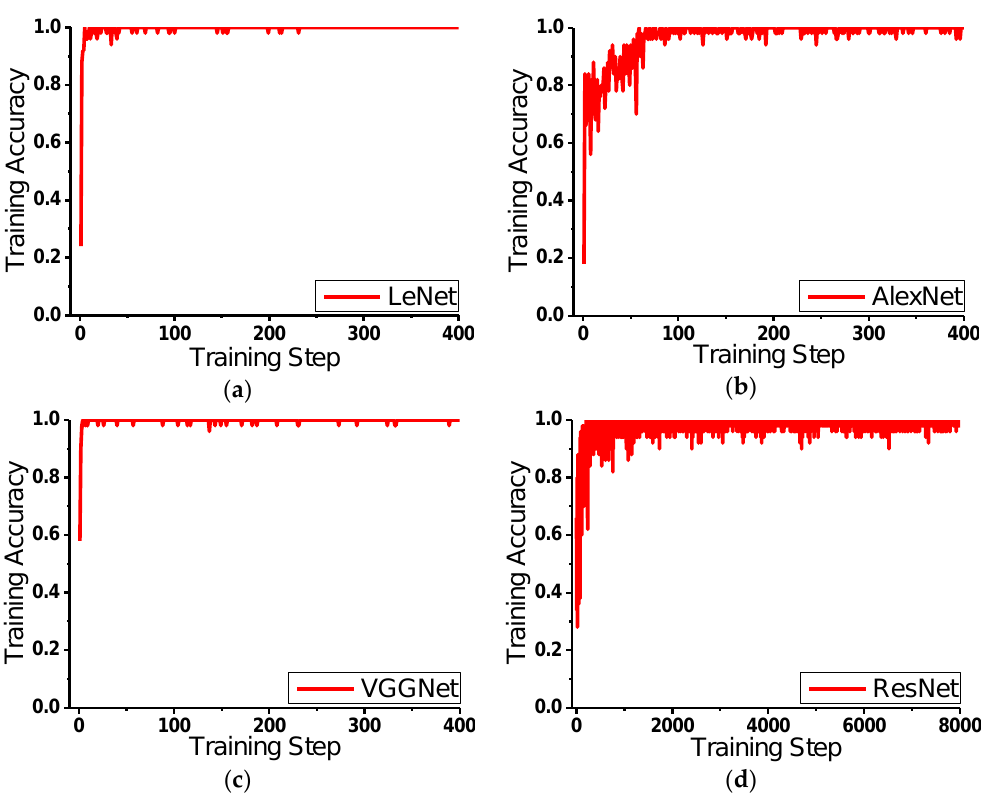
Figure 8. Training process of four CNNs: ( a ) training curve of LeNet; ( b ) training curve of AlexNet; ( c ) training curve of VGGNet; ( d ) training curve of ResNet.